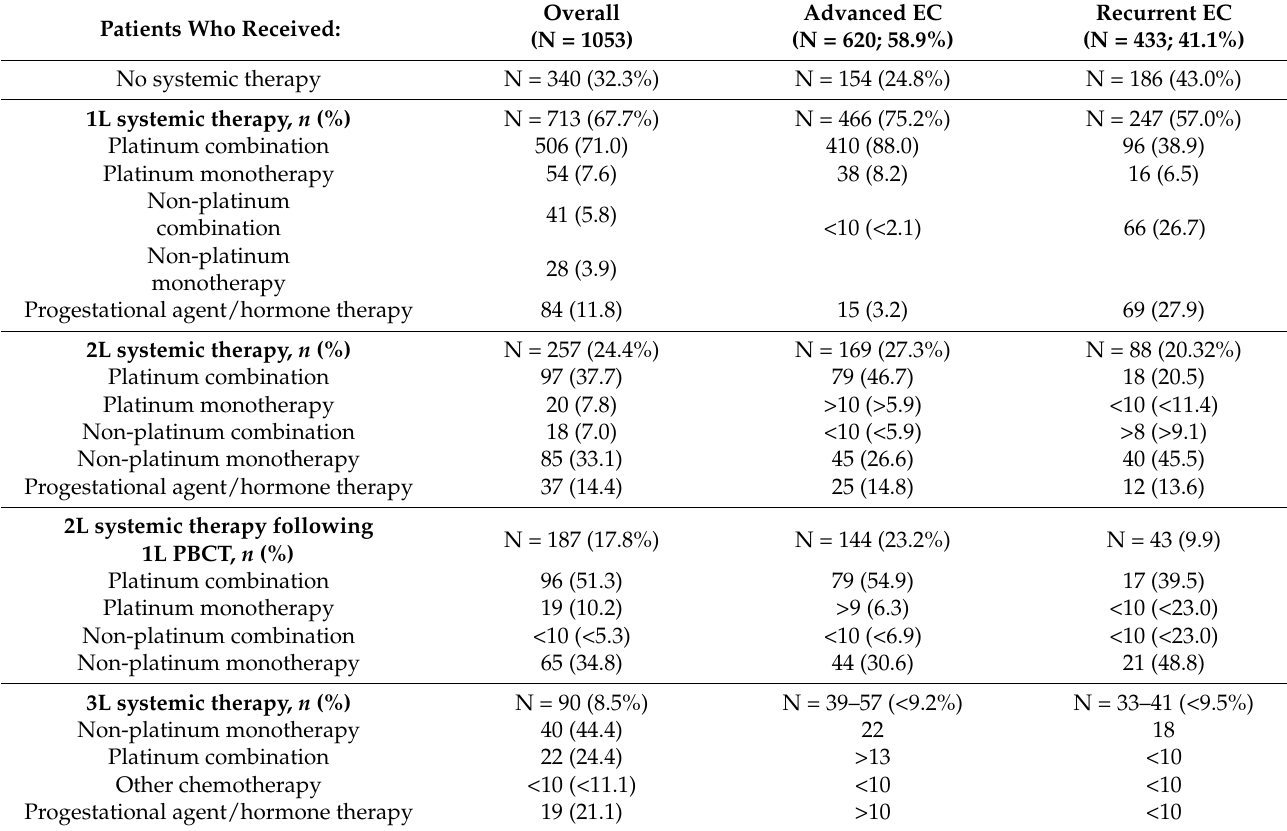
Table 2. Treatment patterns for patients with advanced and recurrent